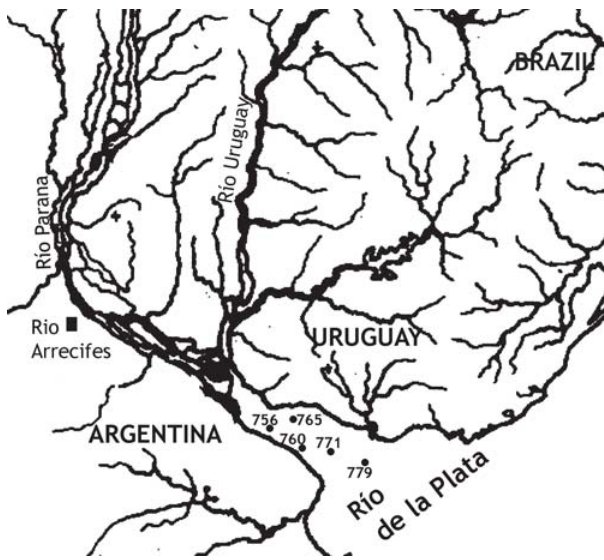
Fig. 2. Map showing the collecting sites of Pimelodus albicans. The square represents the río Arrecifes, the remaining localities are indicated in the río de la